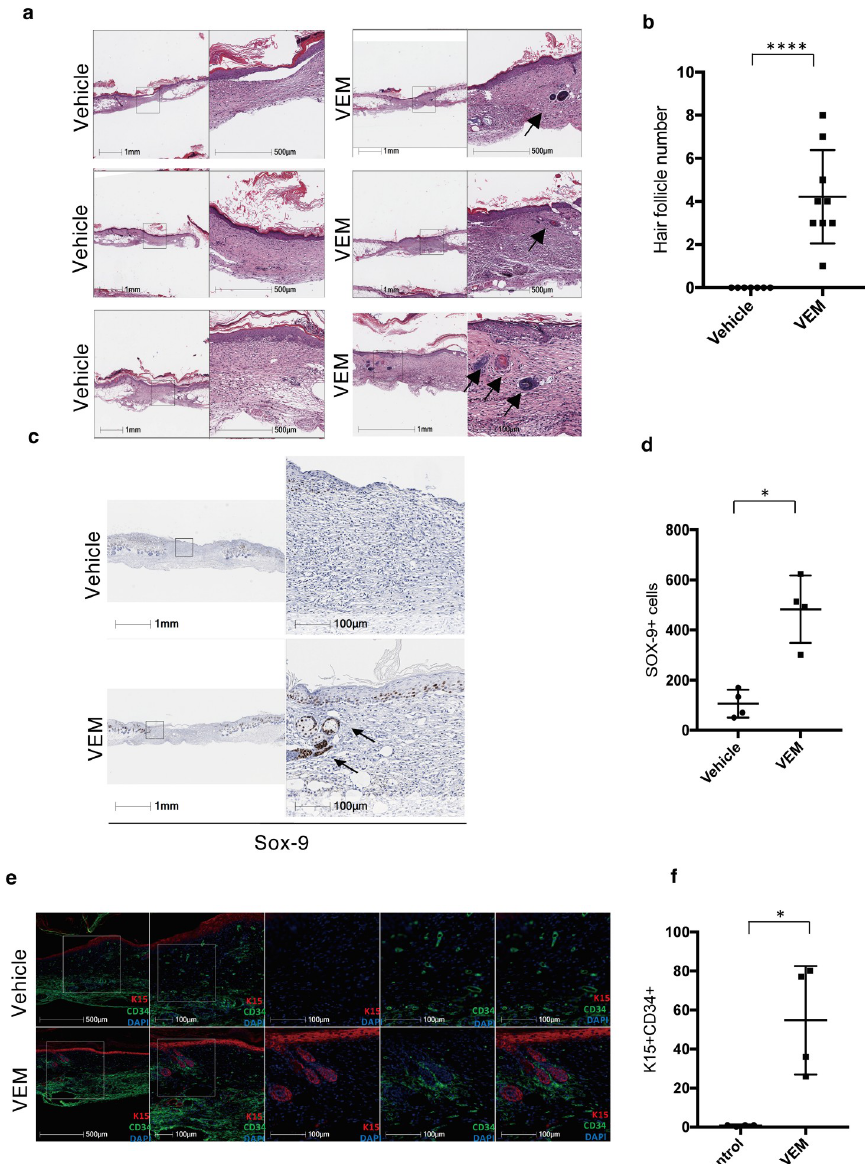
Fig 3. Topical vemurafenib promotes hair follicle regeneration in db/db wounds. (a) Representative H&E images of vehicle-treated and vemurafenib (vemurafenib)-treated wounds on day 0 and day 16 in diabetic mice. (b) Scatter plots representing the quantification of hair follicles within the wound area ( ���� P = 0.0001) for control wounds versus treated wounds on day 16 in diabetic mice. (c) Representative Sox-9 staining IHC images in the presence and absence of vemurafenib in db/db mice wounds by day 16. (d) Scatter plot representing the quantification of Sox-9+ cells ( � P = 0.02, n = 4) for control wounds versus treated wounds on day 16. (e) Representative CD34, K15 and DAPI staining IF images in the presence and absence of vemurafenib in db/db mice wounds by Day 16. (f) Scatter plots representing the quantification of CD34+ K15+ cells for control wounds versus treated wounds ( � P = 0.02). Error bars in b, d and f mean ± s.d. Bar graphs represent one experiment with 4–9 replicates per